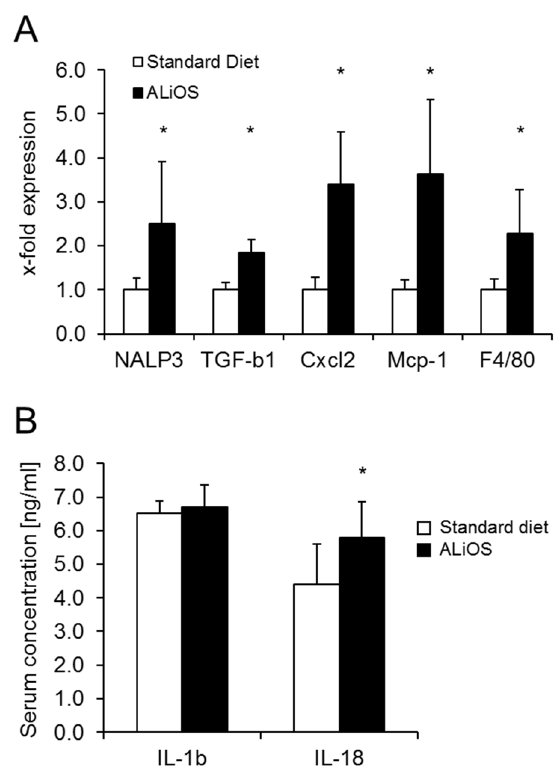
Figure 3. Engagement of the inflammasome pathway following ALiOS diet Wildtype mice were fed standard diet (white bars) or ALiOS diet (black bars) for 24 weeks. ( A ) Expression of indicated genes in liver tissue and ( B ) serum concentrations of IL-1 β and IL-18 ( n = 8, each) at the end of the study are shown (mean ± standard deviation; n = 6, each; * p < 0.01, t-test).